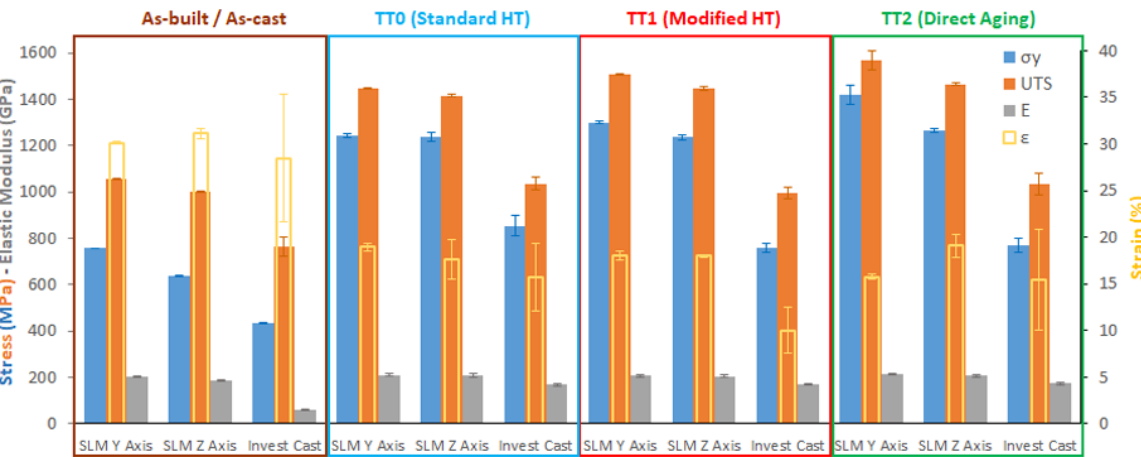
Figure 17. Evolution of mechanical properties with heat treatments for IN718 alloy.